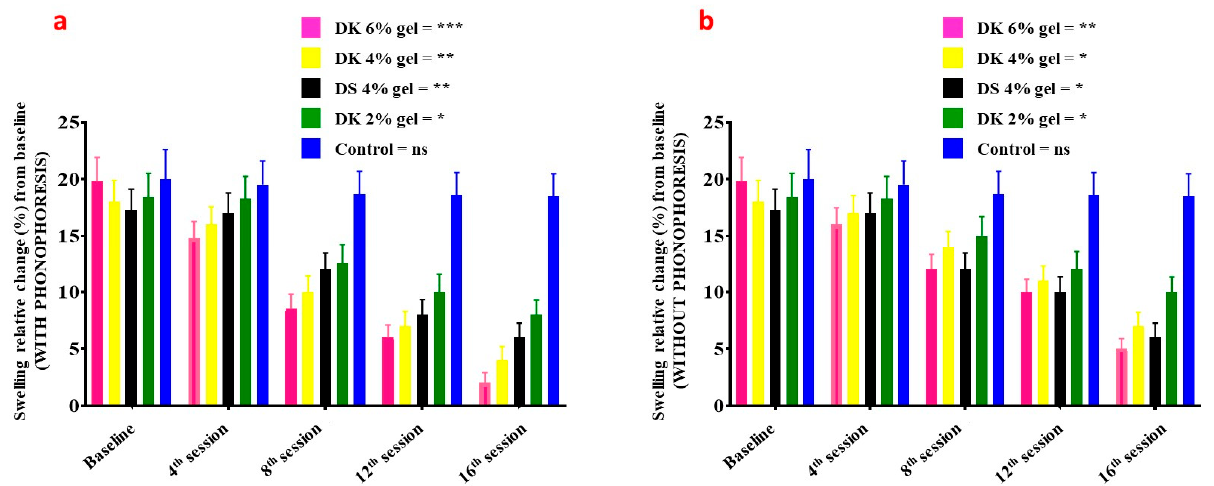
Figure 3. Swelling-related changes on the baseline, 4th session, 8th session, 12th session, and 16th session of Diclofenac potassium (DK) treatment ( a ) with phonophoresis ( b ) without phonophoresis, in sports-injured patients. Diclofenac sodium (DS) was used as a standard control. Control group is the placebo. Statistical significance ( p -values) is detailed in the main text. ns = no significant; p < 0.05 *, p < 0.01 **, p < 0.001 ***. NPRS in patients treated with gel combined with phonophoresis was significantly decreasing in a dose-dependent manner (Figure 4a): 6% DK gel ( p = 0.009–0.000), 4% DK gel ( p = 0.08–0.02), 2% DK gel ( p = 0.08–0.03), 4% DS gel ( p = 0.08–0.02) and for placebo ( p = 0.09–0.07). Comparatively to patients receiving gel but without phonophoresis, NPRS was also significantly decreasing in a dose-dependent manner (Figure 4b): 6% DK gel ( p = 0.009–0.03), 4% DK gel ( p = 0.09–0.04), 2% DK gel ( p = 0.08–0.04), 4% DS gel ( p = 0.08–0.04), and for placebo ( p = 0.09–0.08).